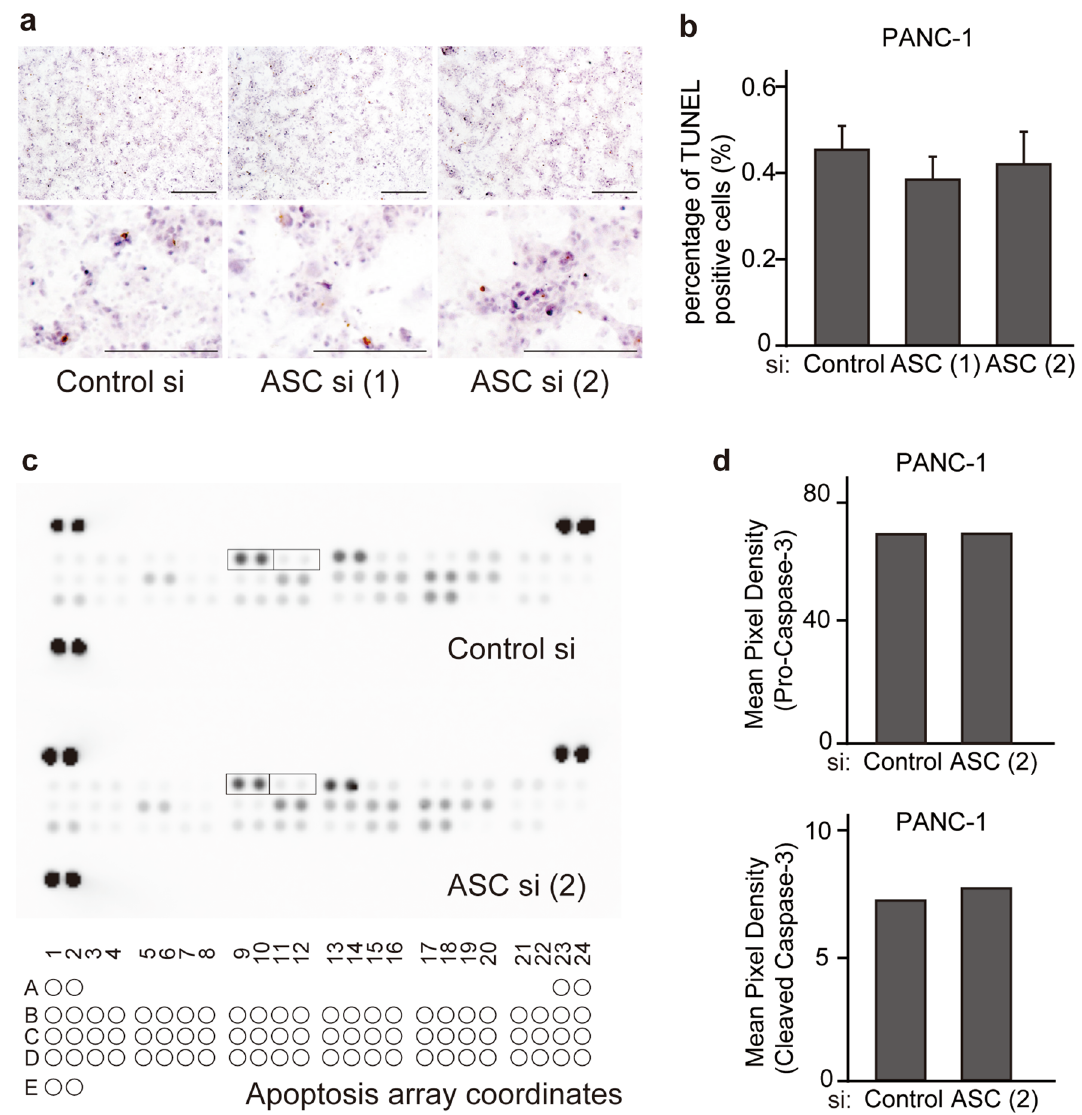
Figure 7. ASC silencing does not induce apoptosis-related changes in PDAC cells. ( a ) IHC staining of PANC-1 cells to detect apoptosis induction and TUNEL staining at 72-h post-transfection with control and ASC siRNA. Scale bar: 500 µm. ( b ) Quantitation of apoptotic cells based on TUNEL staining at 72-h post-transfection with control and ASC siRNA. Data represent the mean ± standard error of the mean of five areas. ( c ) Changes in the expression of apoptosis-related proteins at 72-h post-transfection with control and ASC (2) siRNA in PANC-1 cells and analyzed using human apoptosis proteome profiler arrays. Boxes show the localization of procaspase-3 and cleaved caspase-3 on the membrane. The cytokine array coordinates are as follows: positive ctrl (A1, A2); positive ctrl (A23, A24); Bad (B1, B2); Bax (B3, B4); Bcl-2 (B5, B6); Bcl-x (B7, B8); procaspase-3 (B9, B10); cleaved caspase-3 (B11, B12); catalase (B13, B14); cIAP-1 (B15, B16); cIAP-2 (B17, B18); claspin (B19, B20); clusterin (B21, B22); cytochrome c (B23, B24); TRAIL R1/DR4 (C1, C2); TRAIL R2/DR5 (C3, C4); FADD (C5,